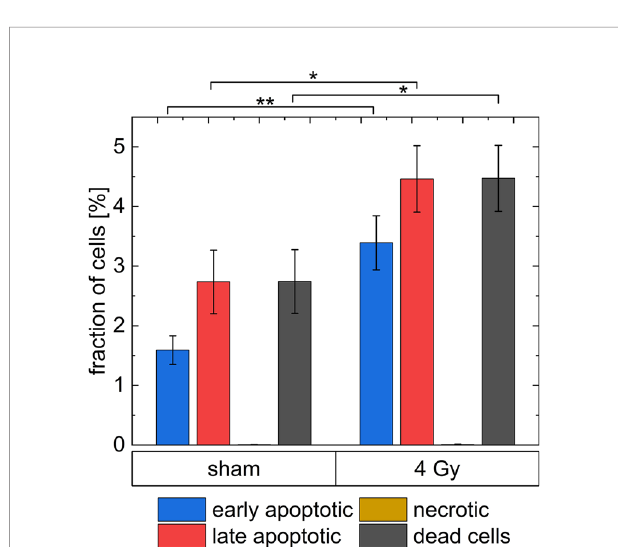
FIGURE 9 | The analysis of dead cells 24 h after irradiation with 4 Gy of 20 MeV protons with a Caspase3/7-Sytox assay. * indicates a p-value < 0.1 and ** a p-value < 0.05. The uncertainties shown as error bars are the standard errors of the respective